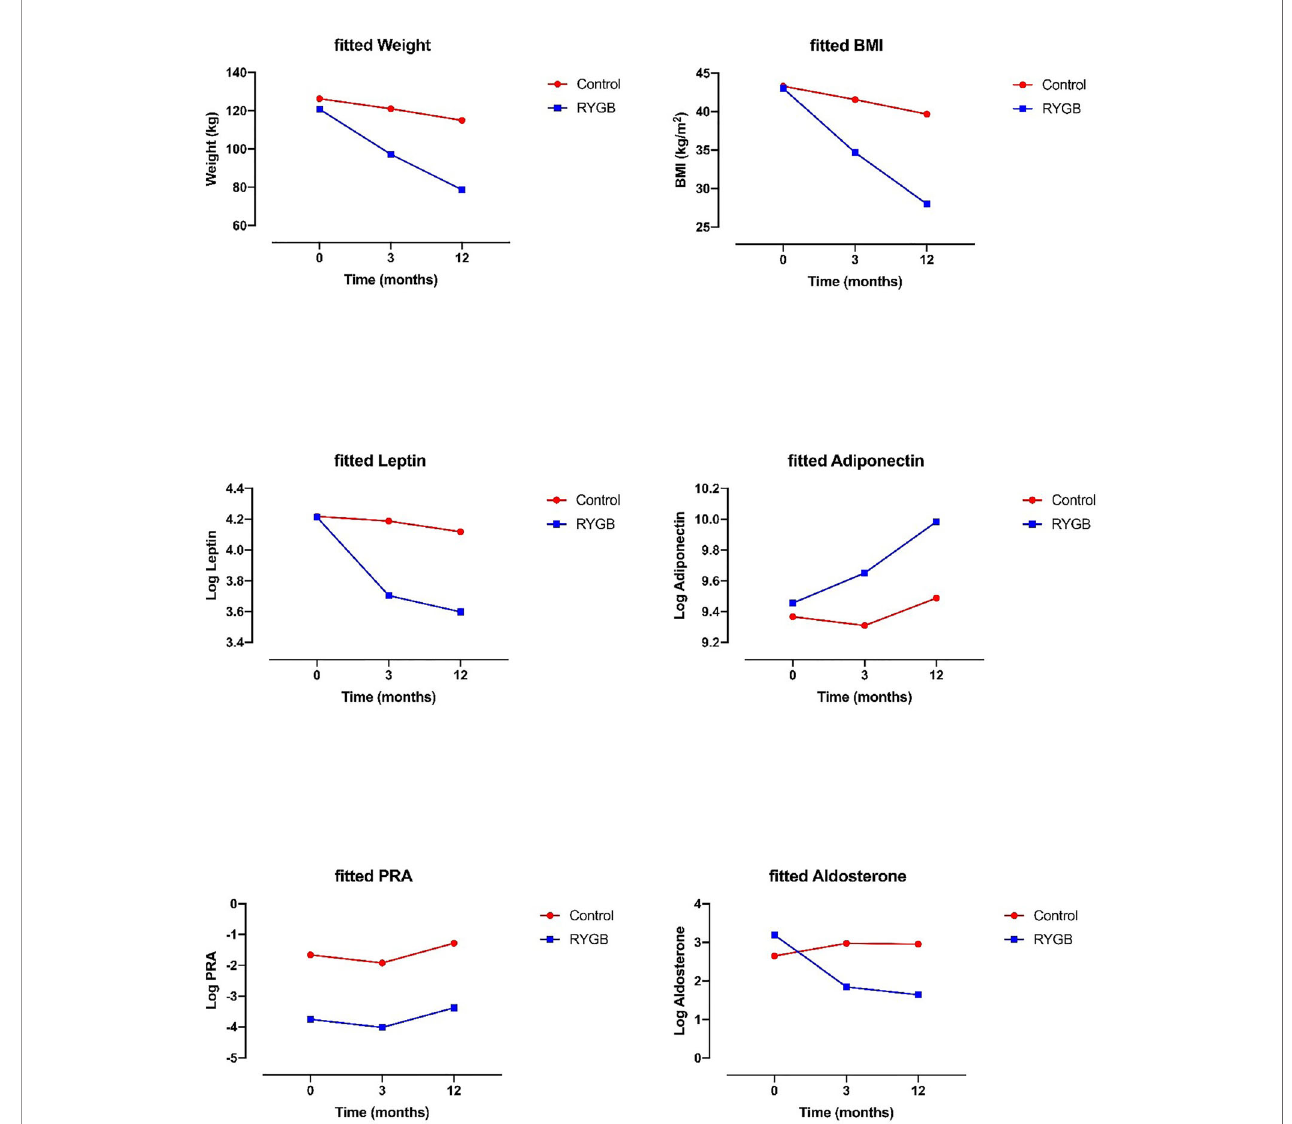
FIGURE 1 | Effect of RYGB on weight, BMI, leptin, adiponectin, plasma renin activity, and aldosterone. Data on graphs are fi tted from linear mixed model